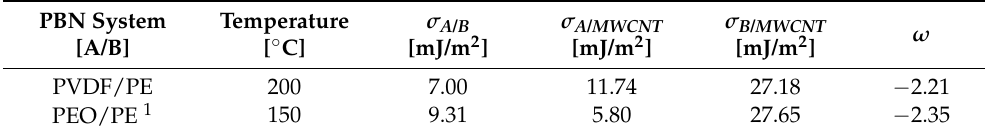
Table 2. Surface Energy and Wettability Data for PVDF/PE and PEO/PE Blend Systems Containing MWCNTs (calculated based on geometric mean) [29].